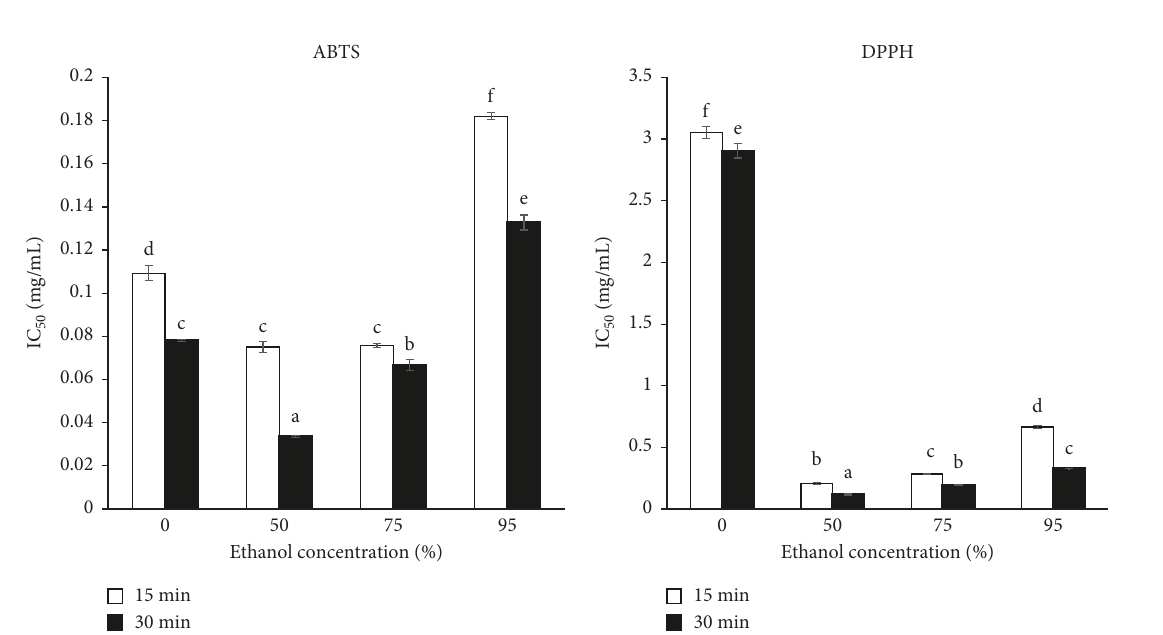
Figure 1: Antioxidant activity of dill extracts. Table 2: Total phenolic compounds, total favonoid content, and antioxidant activity of dill extracts from UAE and CE.